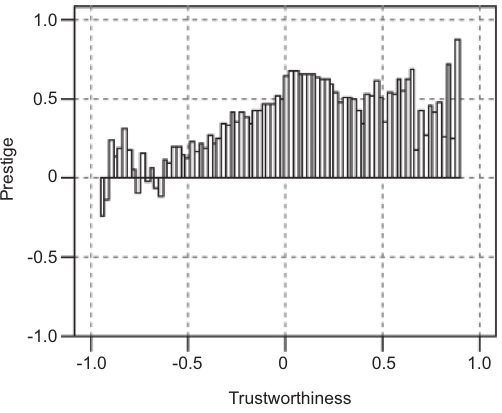
Figure 5. Comparison of Trustworthiness and Prestige for Slashdot